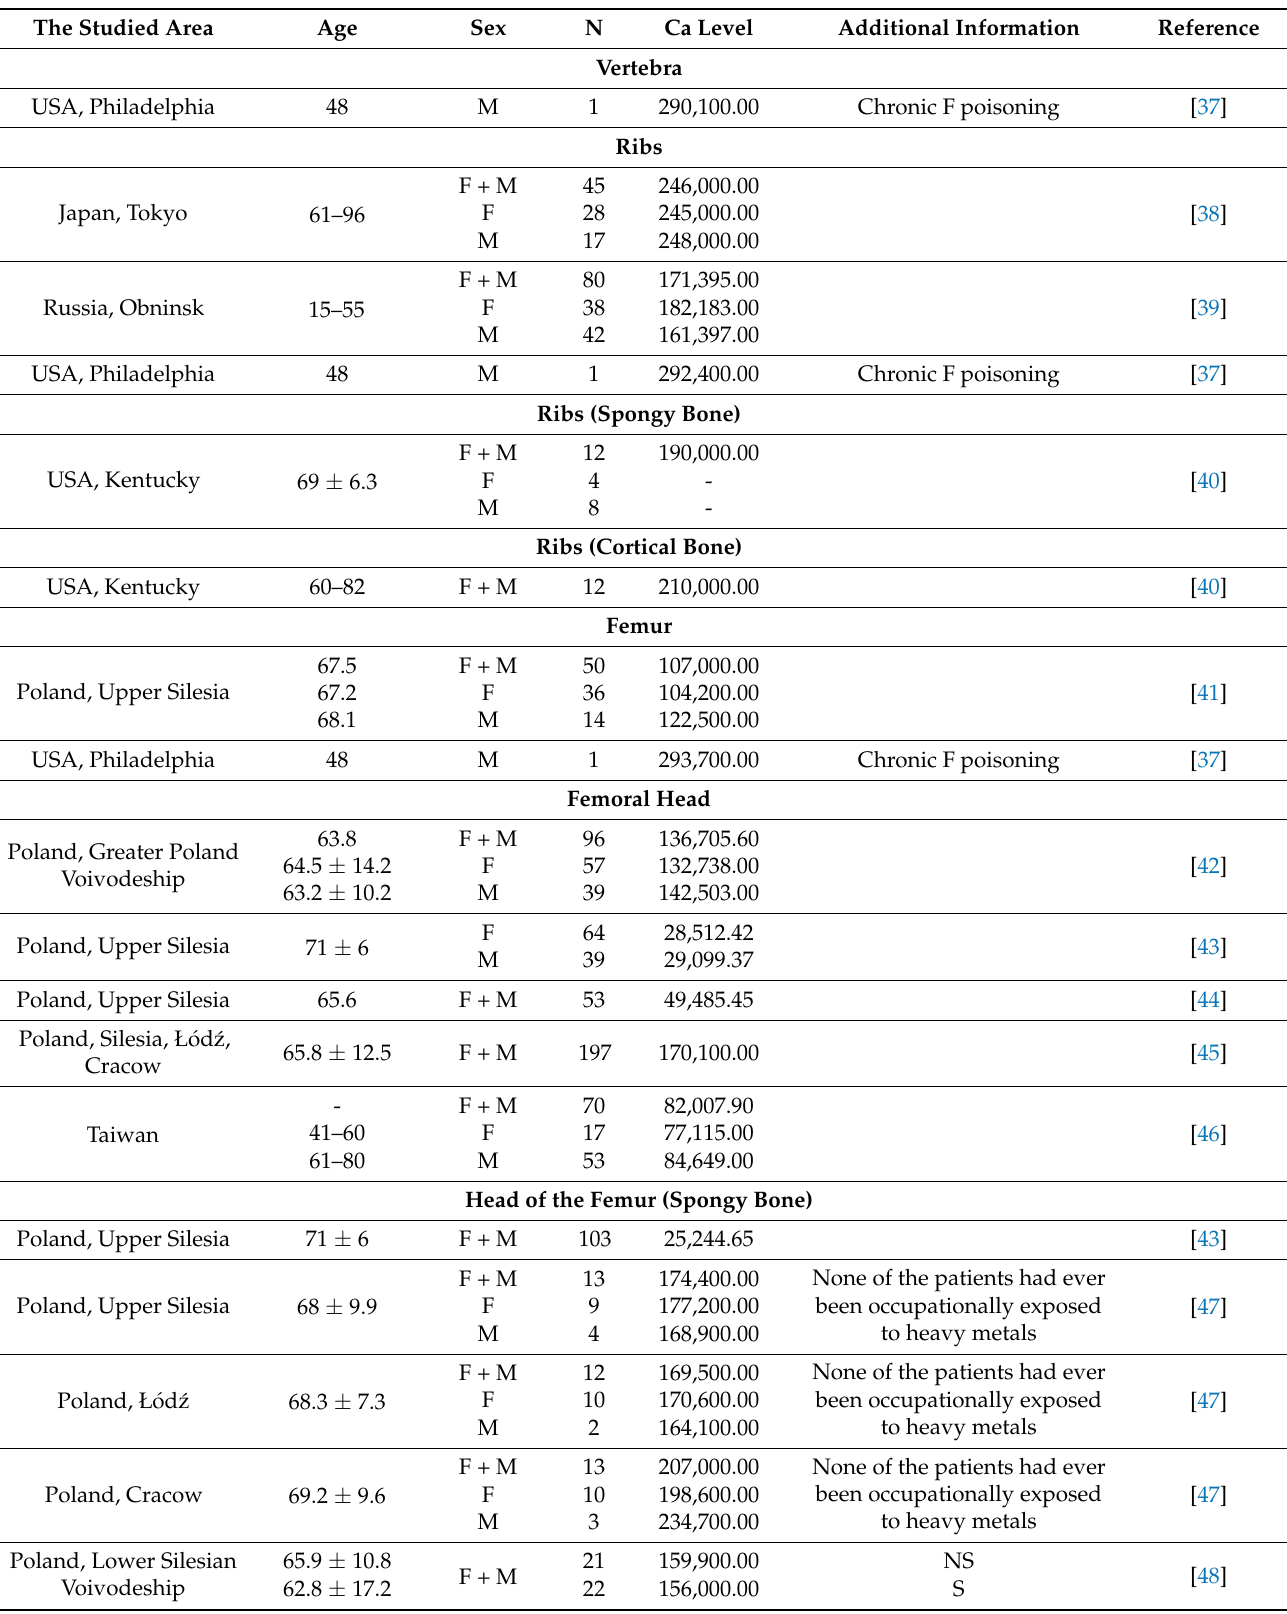
Table 1. Calcium levels in human bones in mg kg − 1 dw. (F, female; M, male; N, number of participants; NS, nonsmoking; S,